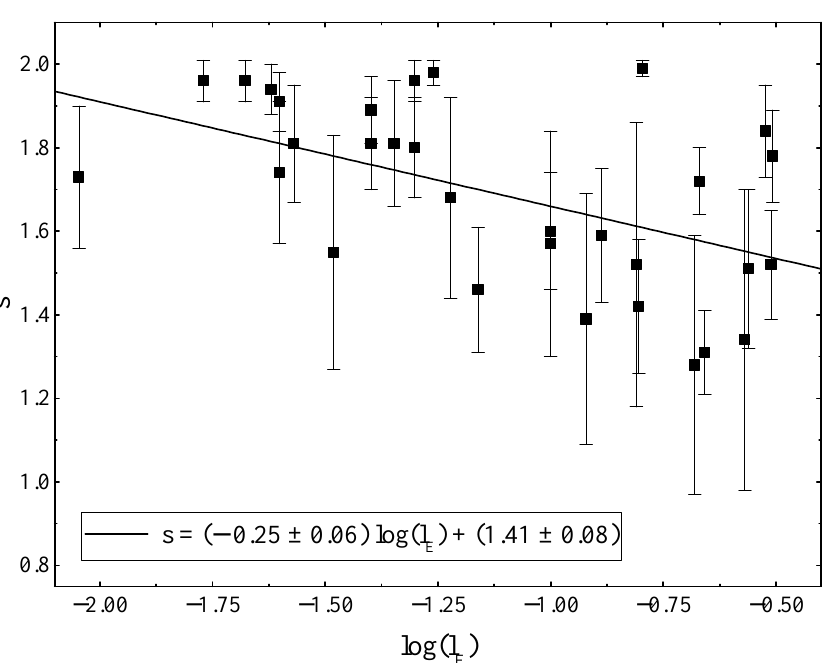
Figure 11. Dependence of the exponent of the power-law dependence s on the Eddington ratio l E .